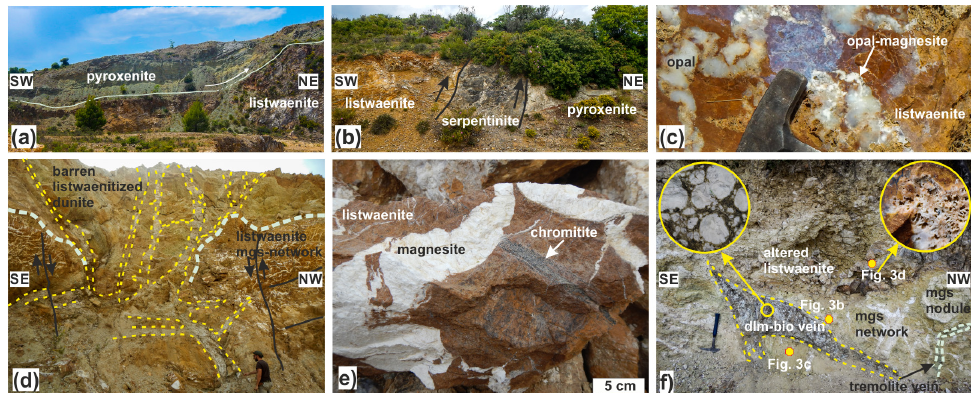
Figure 2. Selective field photos ( a ) contact between unaltered massive pyroxenite and listwaenite with magnesite stockwork; ( b ) fault-zone serpentinite body developed between the contact of listwaenite and pyroxenite ( c ) listwaenite cross-cut by opal and magnesite; ( d ) barren listwaenite overlying magnesite bearing listwaenite, whitish veins are composed of dolomite-chlorite; ( e ) listwaenite hosting both chromite and magnesite ore ( f ) vein consisting of nodular dolomite and biotite cross- cutting altered listwaenite, Figure 3b–d (black dots represent where the samples were collected) stand for the XRD patterns presented in Figure 3. Abbreviations: mgs =